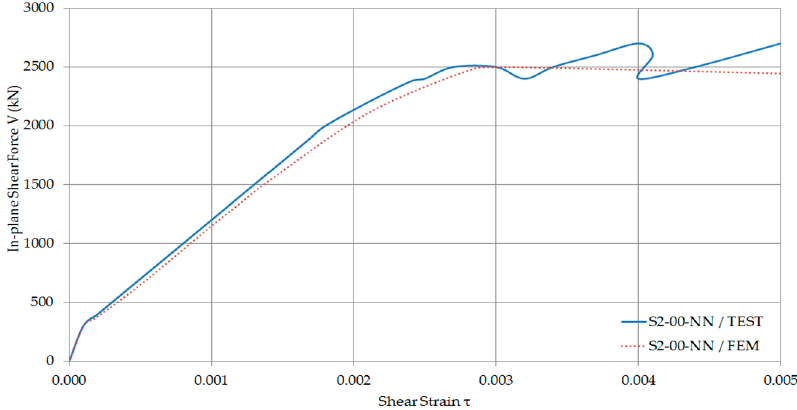
Figure 14. In-plane shear force—Shear strain Curves of S2-00-NN.